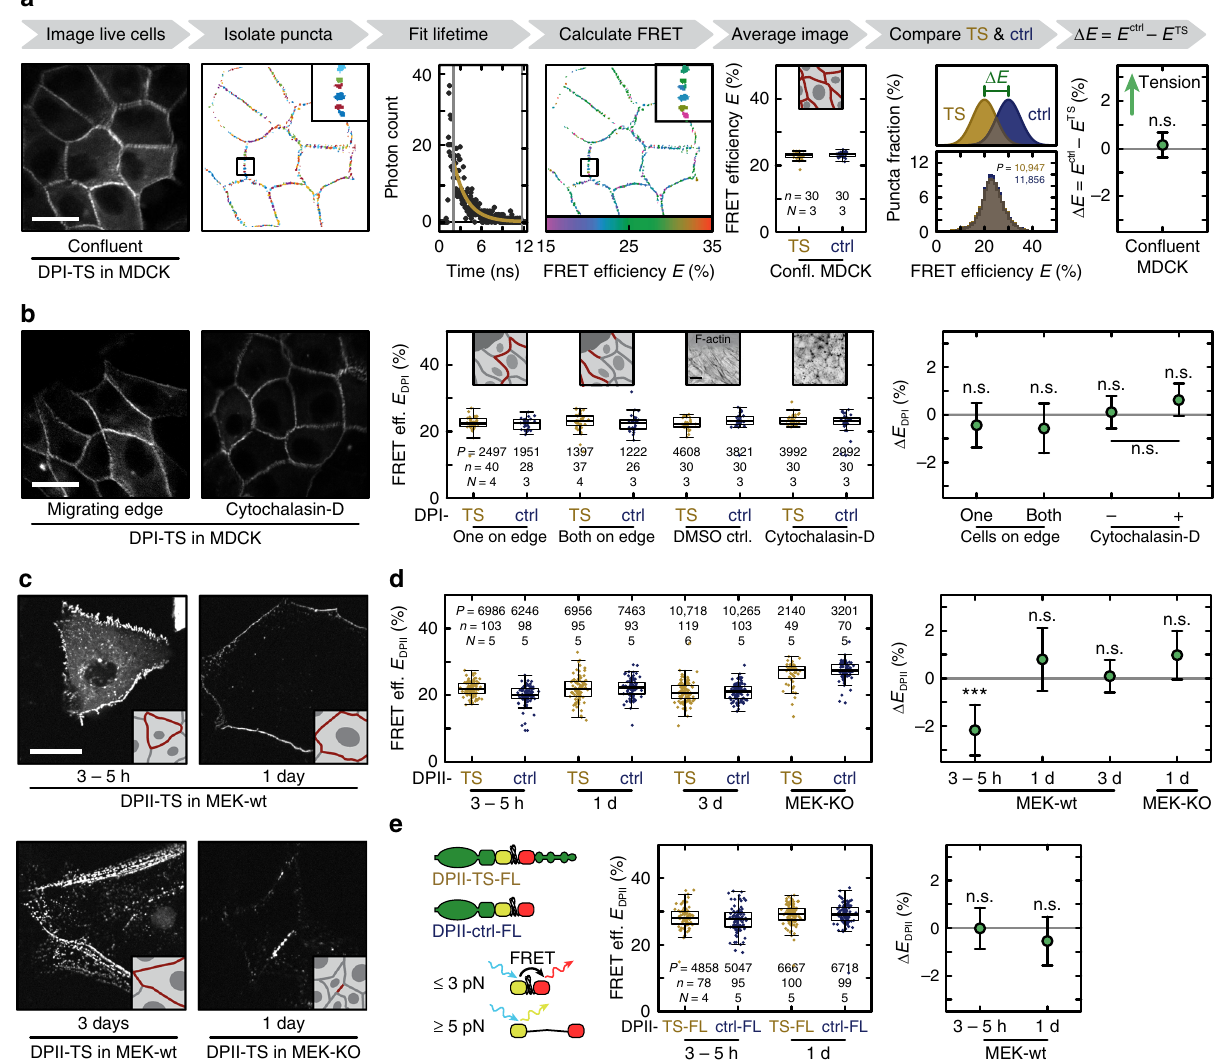
Fig. 2 Desmoplakin tension is negligible under homeostatic conditions. a Donor intensity signals were masked and thresholded to generate a segmentation map of individual DSM puncta. For each punctum, a fl uorescence lifetime was determined and the corresponding FRET ef fi ciency calculated. FRET ef fi ciencies for DPI-TS (yellow) and DPI-ctrl (blue) were indistinguishable in con fl uent MDCK monolayers. The median FRET ef fi ciency per image is shown as a boxplot and re fl ects the underlying distributions of individual puncta values that were used to calculate the mean change in FRET ef fi ciency as Δ E = E ctrl − E TS . b No FRET ef fi ciency differences were observed at the edge of migrating MDCK cell sheets in cell – cell junctions categorized as having one or both cells on the colony edge. Similarly, treatment of con fl uent MDCK monolayers with the actin-destabilizing drug cytochalasin-D (see Supplementary Fig. 2c for immuno- staining) did not induce a signi fi cant change in FRET ef fi ciency. c DPII constructs were expressed in MEK-wt monolayers and imaged at distinct time points after DSM induction (3 – 5h, 1 day, and 3 days). MEK-KO were imaged one day after DSM induction. d In all conditions, the mean changes between DPII-TS (yellow) and DPII-ctrl (blue) were consistent with little or no tension, with tension corresponding to Δ E DPII > 0. e No FRET ef fi ciency differences were observed between DPII-TS-FL (yellow) and DPII-ctrl-FL (blue). Scale bars: 20 μ m. Boxplots show median, 25th and 75th percentile with whiskers reaching to the last data point within 1.5× interquartile range. Δ E is plotted as mean difference with 95% CI; lmer-test: *** p <0.001, n.s. (not signi fi cant) p ≥ 0.05. Numbers of puncta ( P ), images ( n ), and independent experiments ( N ) are indicated in the fi gure. Source data are provided as a Source Data fi